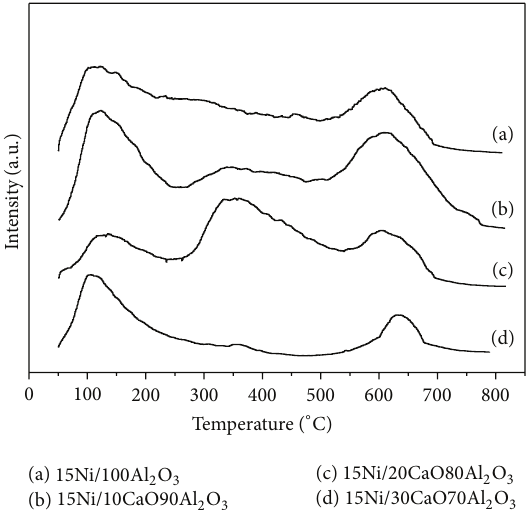
Figure 6: CO 2 -TPD profiles of the catalysts with different CaO contents.